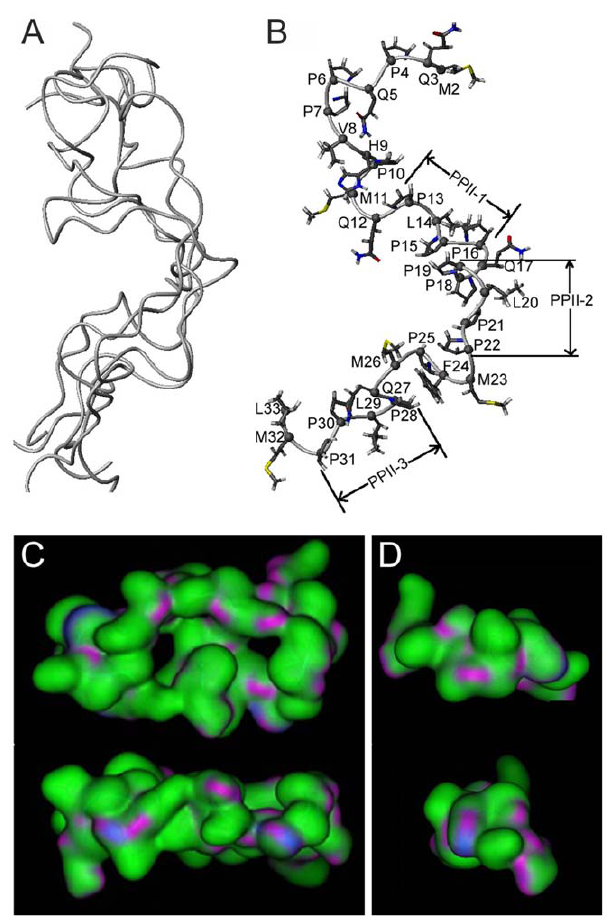
Figure 4. PXX33 atomic structure derived from solution NMR. (A) The five lowest energy structures selected from 200 calculated structures represented in ribbon form. While the overall structure was similar between all five conformations, there was a greater variability at the N-terminal PXX12 region. (B) Backbone ribbon representation and side chain heteroatom representation of one PXX33 lowest energy structure. Three polyproline II helix regions—P13–P16 (PPII-1), P19–P22 (PPII-2), and P28–P31 (PPII-3) —are labeled. (C–D) Increase in